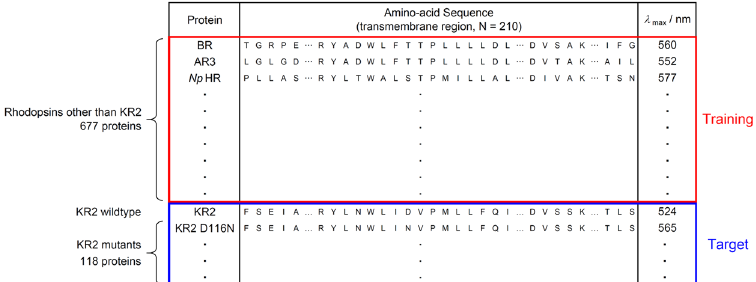
Figure 3. Structure of the database used in the present study. The database is composed of the sequences and λ max s of 519 previously reported proteins and 277 newly reported proteins. We used 677 rhodopsin proteins other than KR2 and their variants as the training proteins (red rectangle) and 119 proteins in KR2 group as the target proteins (blue rectangle),